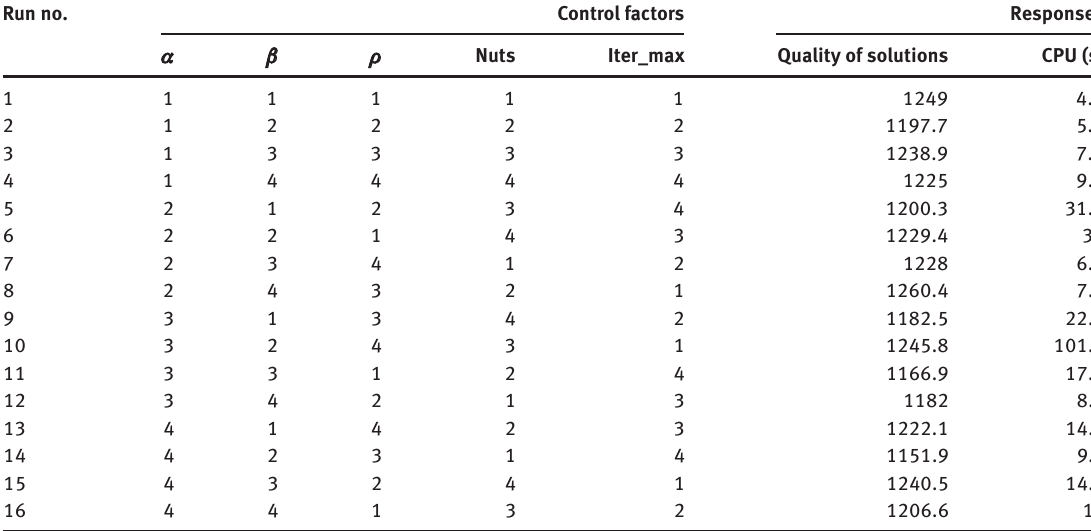
Table 3: Data of Experimental Design. Run